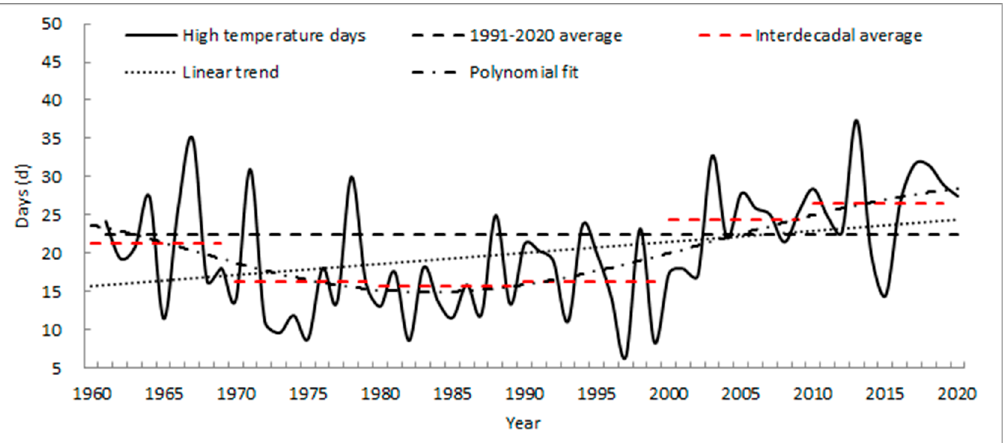
Figure 3. Interannual variation in the annual number of extreme maximum temperature event (EMTE) days in East China during the period 1961–2020 (red dashed line indicates the decadal mean). Table 1. Mann–Kendall test of annual number of extreme maximum temperature event days.